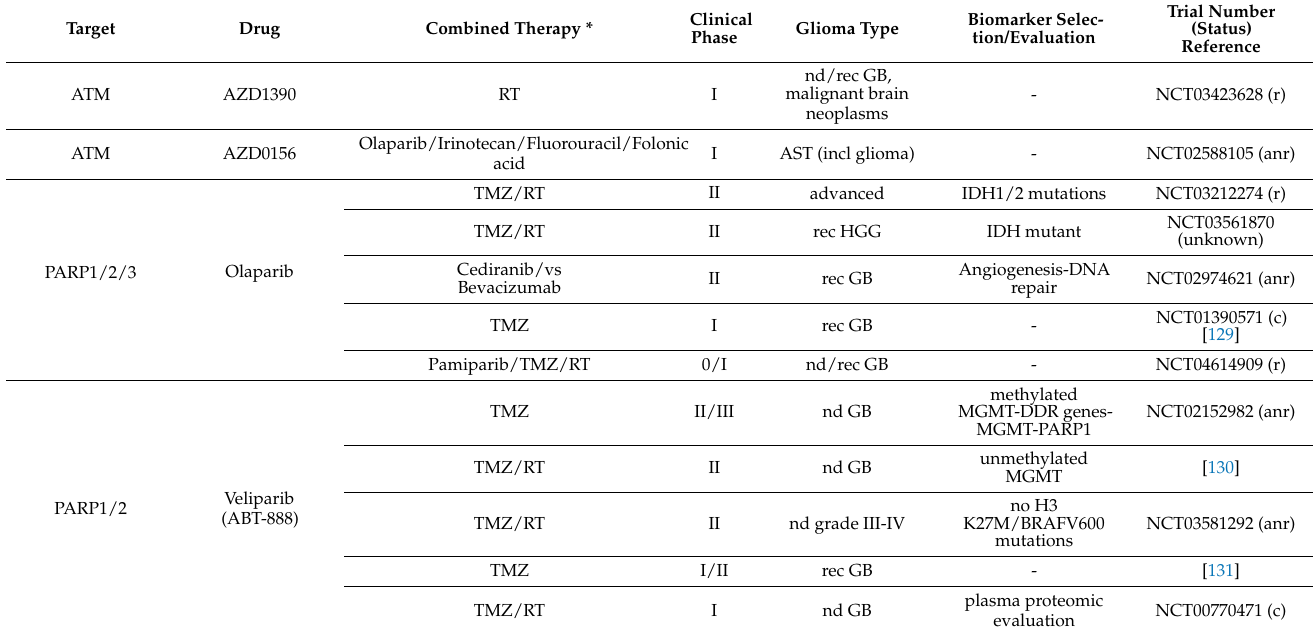
Table 1. Relevant clinical trials concerning DDRi therapy in glioma